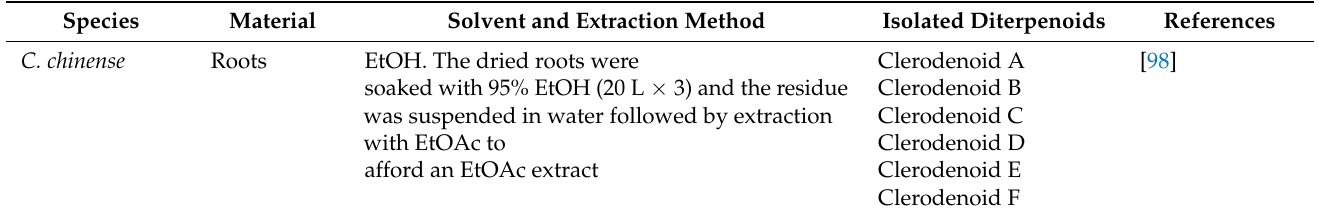
Table 13. The diterpenoid extraction methods and Clerodendrum chinense plant materials for diter- penoid isolation.